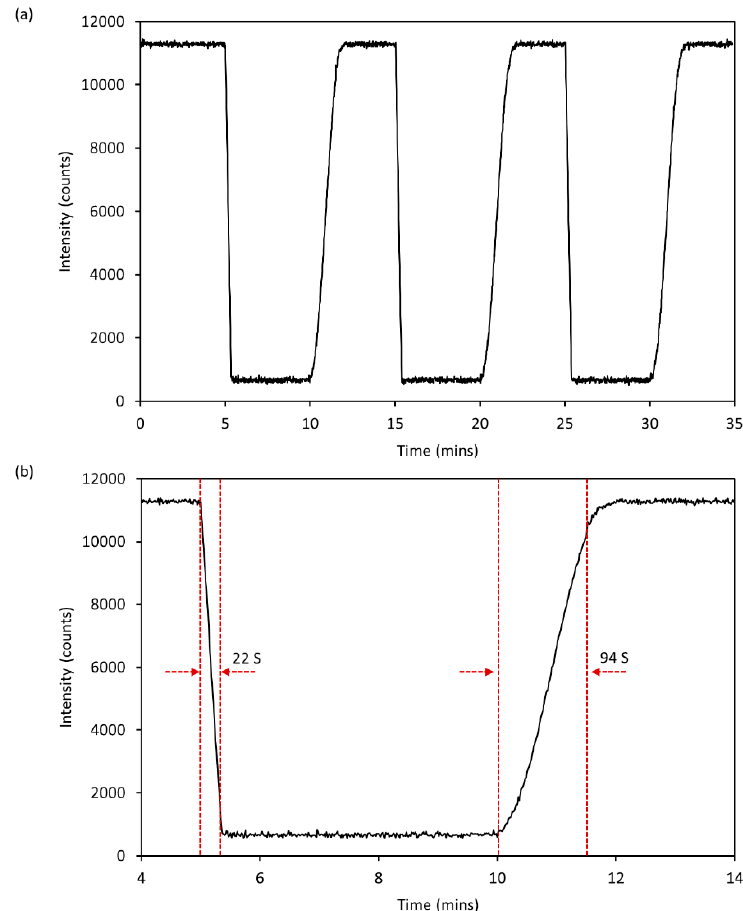
Figure 5. ( a ) Reversible response of the intelligent DO sensor to O 2 -free and O 2 -saturated water samples. ( b ) The partial enlarged curve of ( a ).